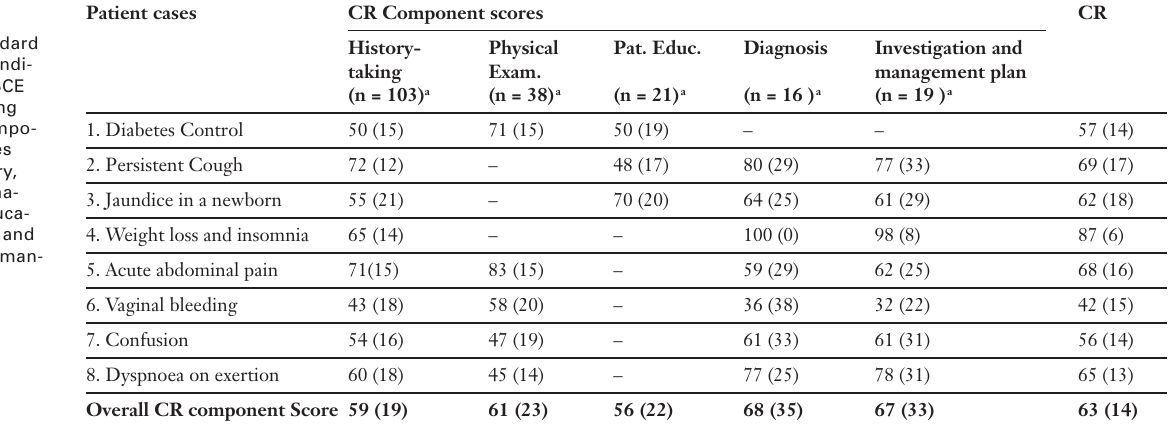
Means, standard deviations, and relia- bility coefficient ( a ) of’ SCE Clinical rea- soning (CR), Commu- nication (Comm), Global (G), Un- weighted total (T) and Weighted total (T w ) score (n = 46).